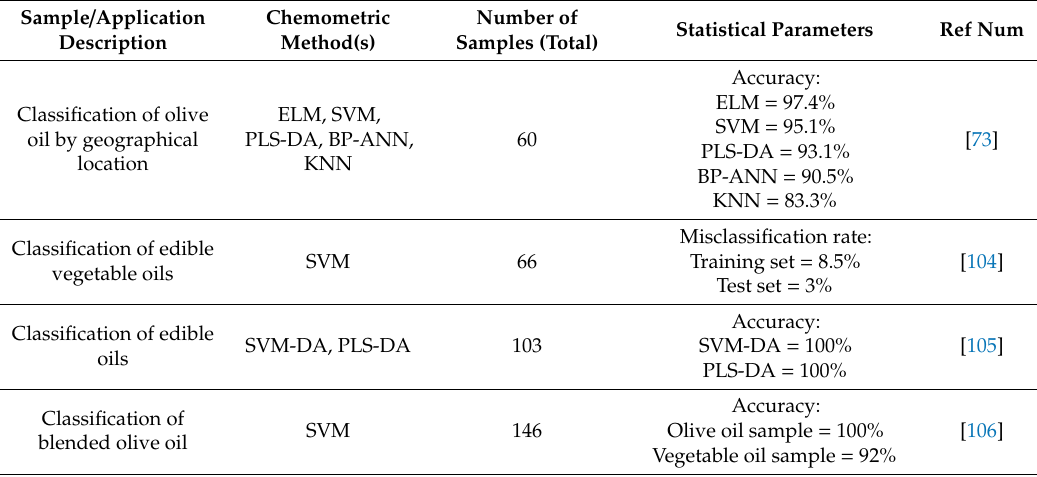
Table 5. Literature related to the use of chemometrics in classification of